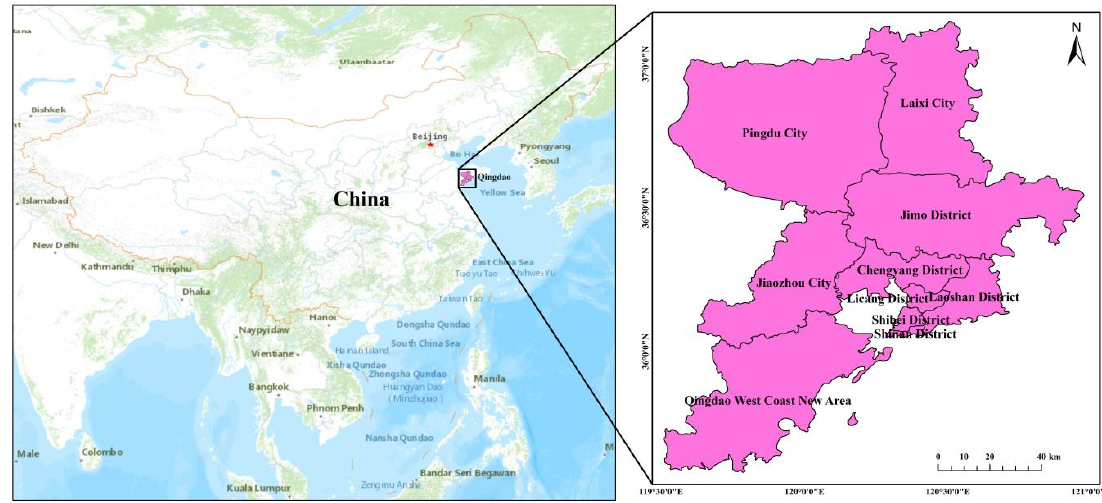
Figure 1. Geographical location of the study